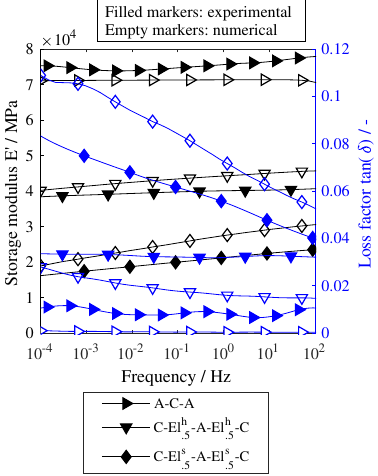
Figure 12. Experimentally and numerically determined master curves for a reverence temperature of 20 ◦ C for selected